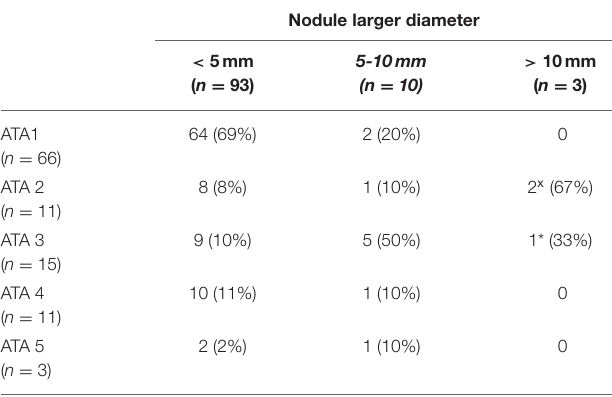
TABLE 1 | Population characteristics. TABLE 2 | Nodules distribution according to the American Thyroid Association classification and nodule dimension (larger diameter was considered) ATA1, benign, purely cystic nodule; ATA2, very low suspicion; ATA3, low suspicion; ATA4, intermediate suspicion; ATA5, high